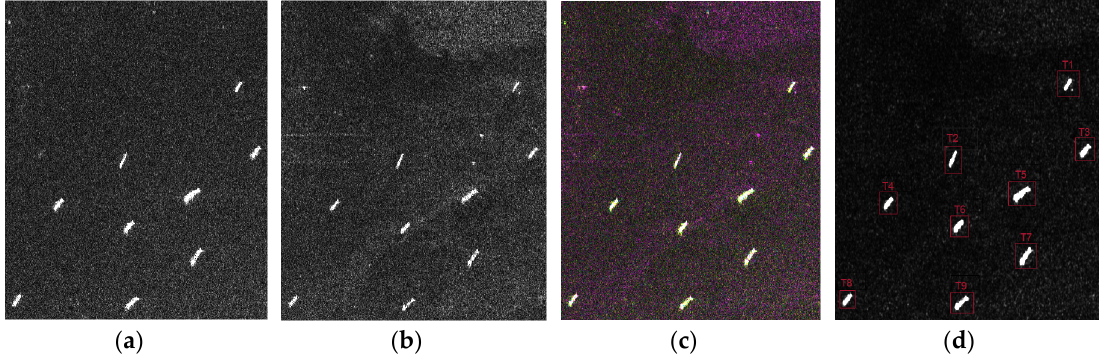
. Figure 1(c) is the image of reflection